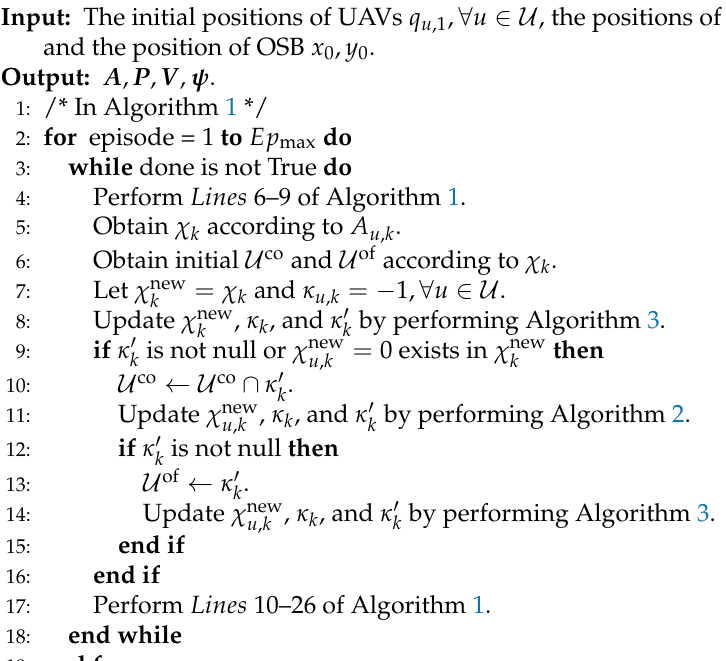
Algorithm 4 Joint optimization algorithm based on SAA, UAA, and MAHPPO (SU-